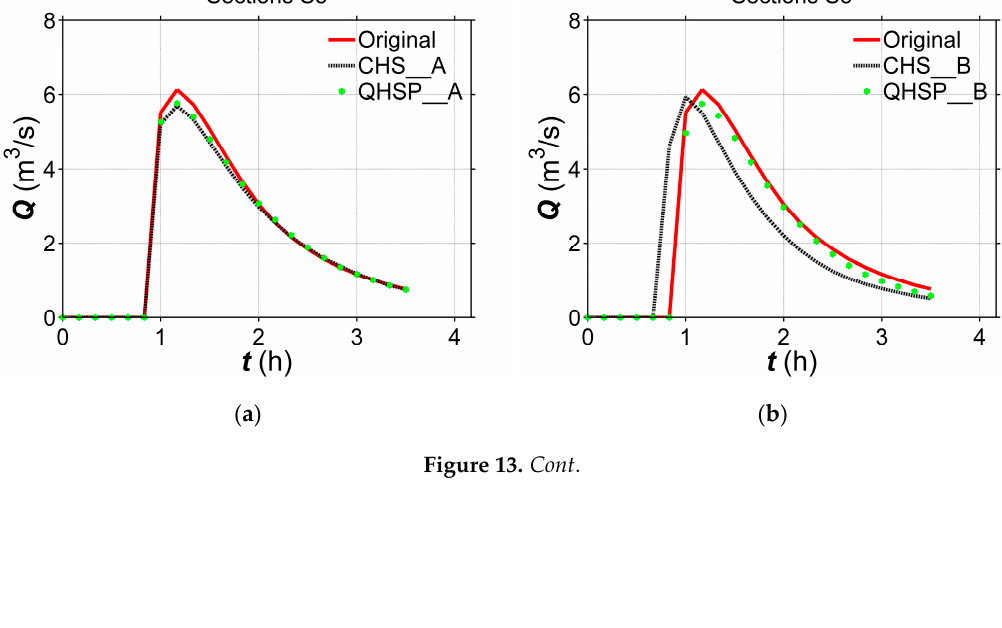
Figure 12. Computed hydrograph for test case ( a ) A, ( b ) B, ( c ) C, and ( d ) D at Section S2 in the constructed river with the amplitude of 600 m.